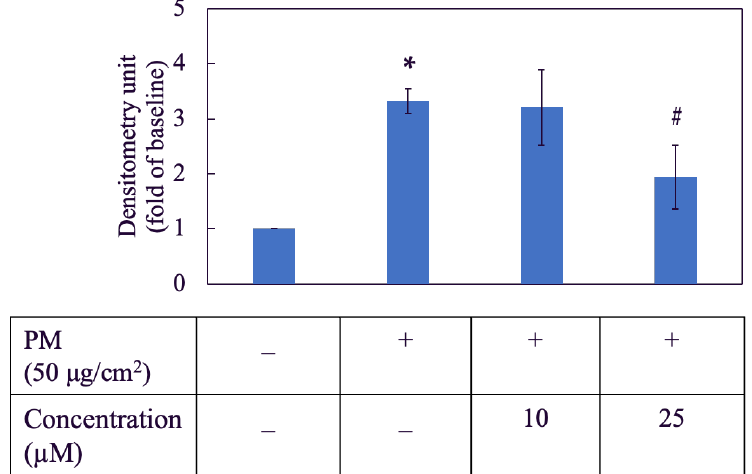
Figure 11. Effect of liposomal morin formulation 7 on PM-induced ROS generation in HaCaT keratinocytes. +, − mean with or without exposing to PM or LMF7. Data were presented as mean ± SD and from triplicate experiments. *, # indicates a statistically significant difference with control group (without treating PM and LMF7) and PM group (only treating LMF7), respectively, p < 0.05.